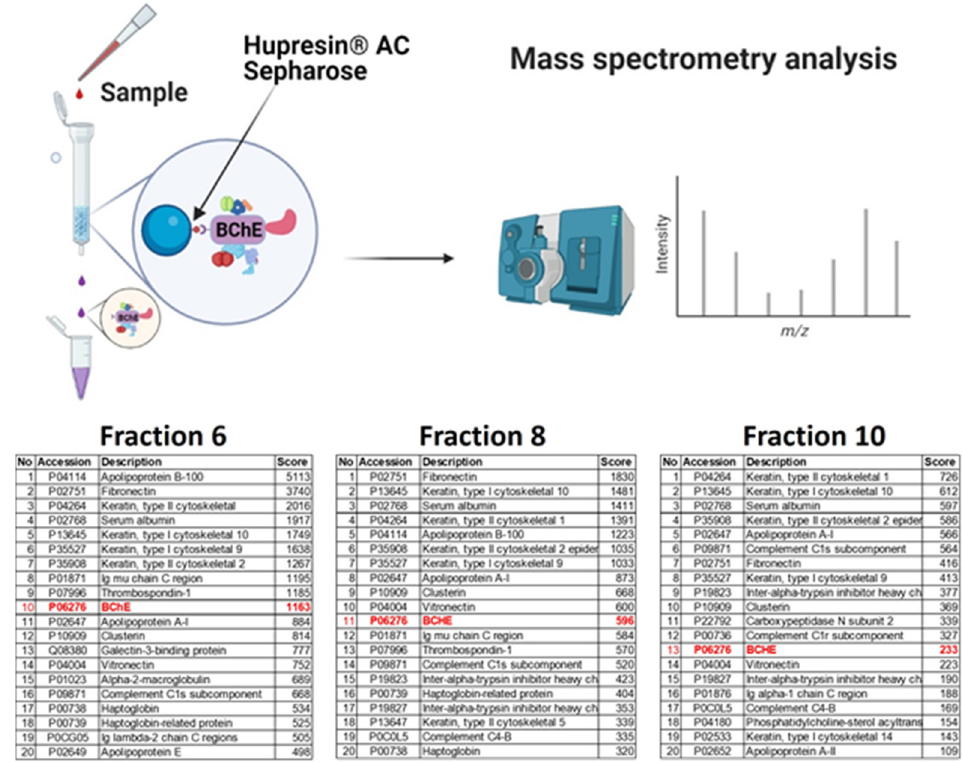
Figure 2. Scheme of the isolation of the BChE–protein complexes by affinity chromatography on Hupresin AC Sepharose. Proteins from fractions 6, 8, and 10 were applied on Hupresin AC Sepharose (Chemforase, Mont-Saint-Aignan, France). The eluted proteins in complexes were identified by